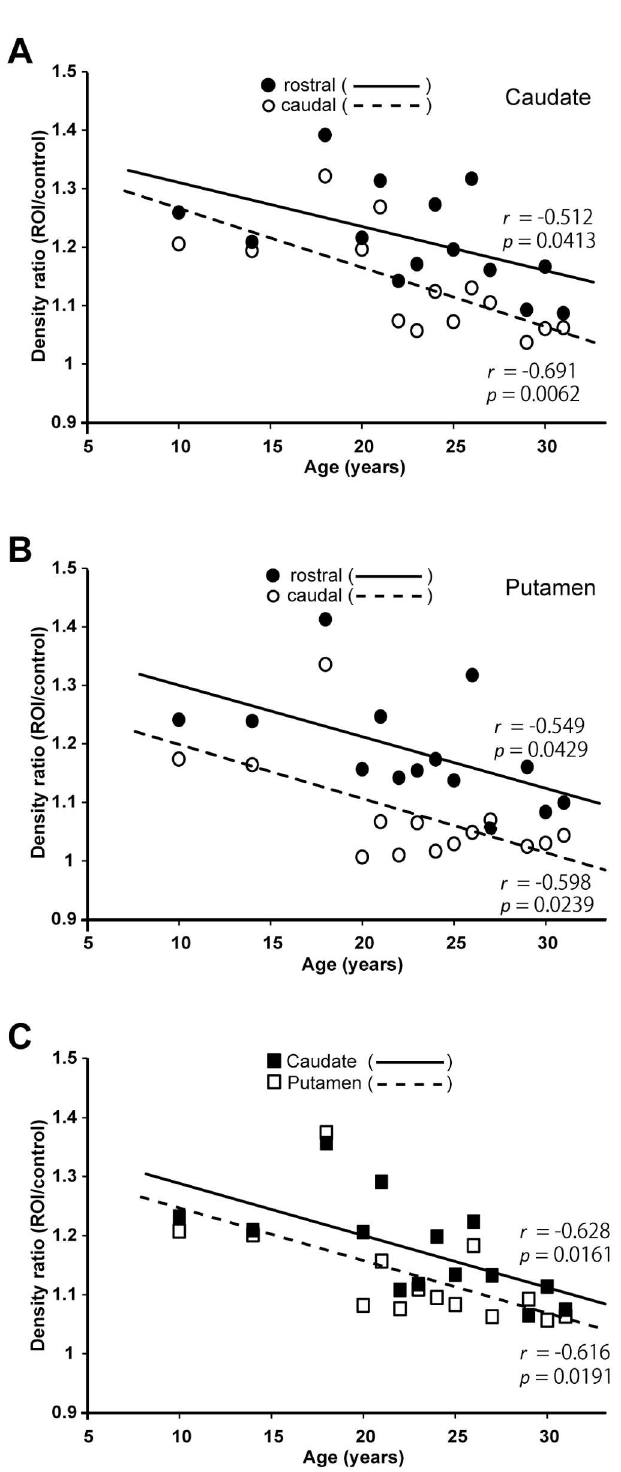
Fig 4. Age-dependent density changes in TH immunoreactivity in the striatum. A: Changein TH immunoreactivity in the caudate nucleusat the rostral or caudallevel. The density ratio was measuredin comparisonwith background staining in the internalcapsule as a control. The solid line with filled circles or brokenline with open circles representsthe density ratio at the rostral or caudallevel, respectively. B: Change in TH immunoreactivity in the putamenat the rostral (denotedby the solid line with filled circles) or